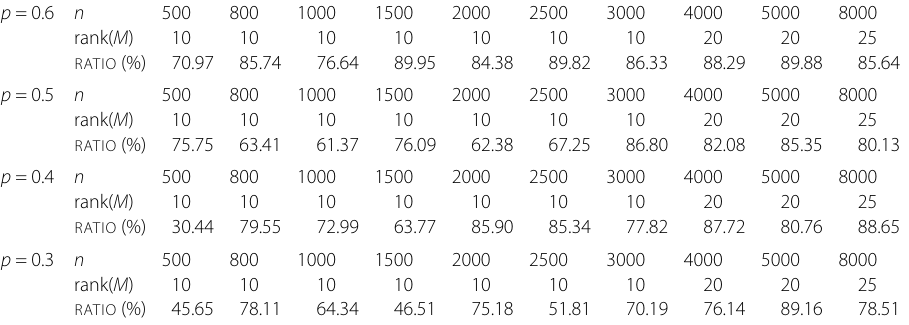
Table 5 The values of RATIO for (cid:11) = 2 p = 0.6 n